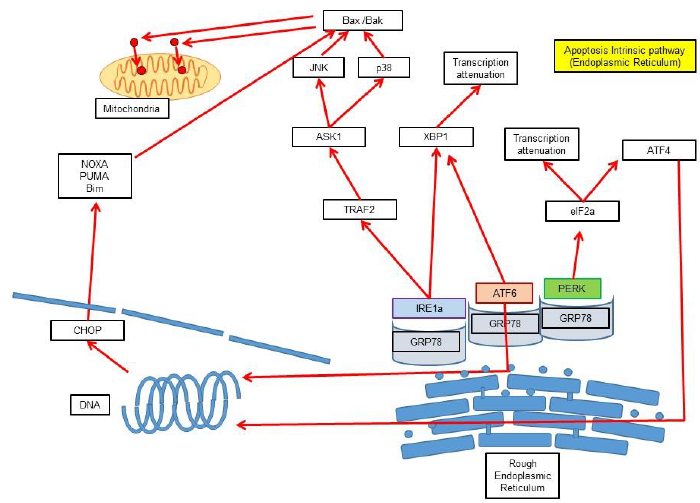
Figure 2. Apoptosis intrinsic (endoplasmic reticulum (ER)) pathway. Schematic representation of